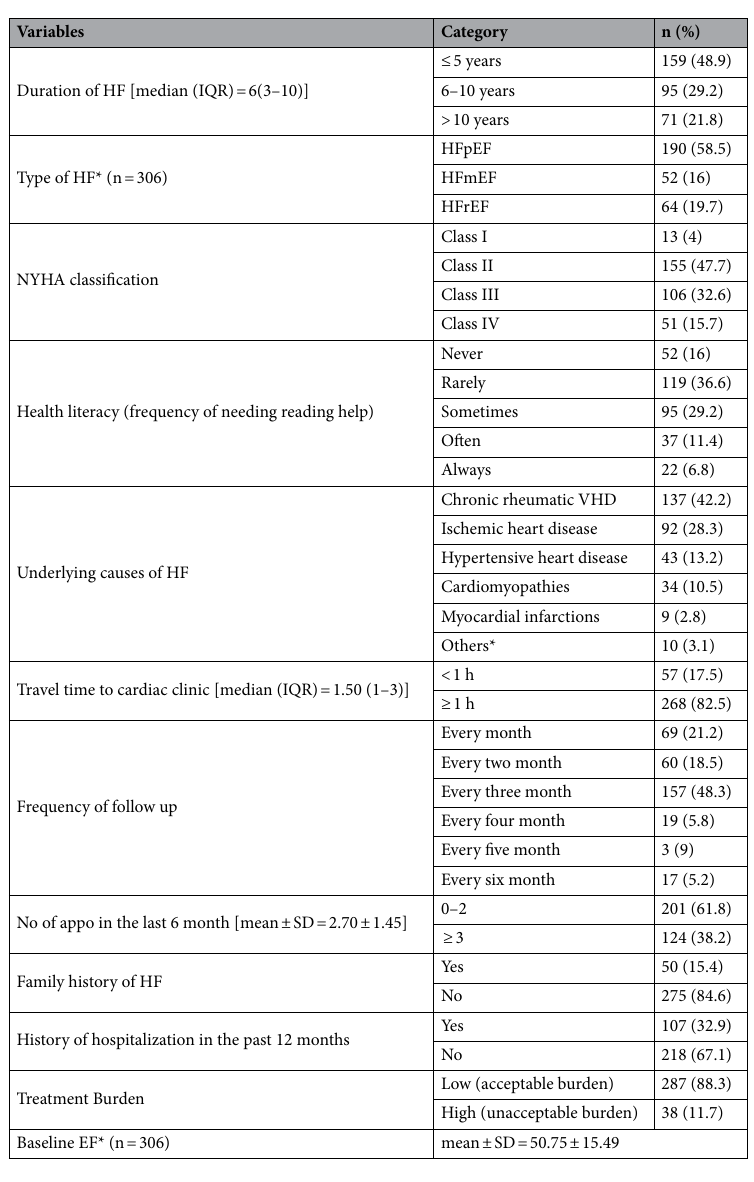
Table 2. Clinical characteristics of patients with heart failure attending cardiac clinic of Tikur Anbessa Specialized Hospital, Addis Ababa, Ethiopia, August 01–September 30, 2021 (n = 325). EF ejection fraction,